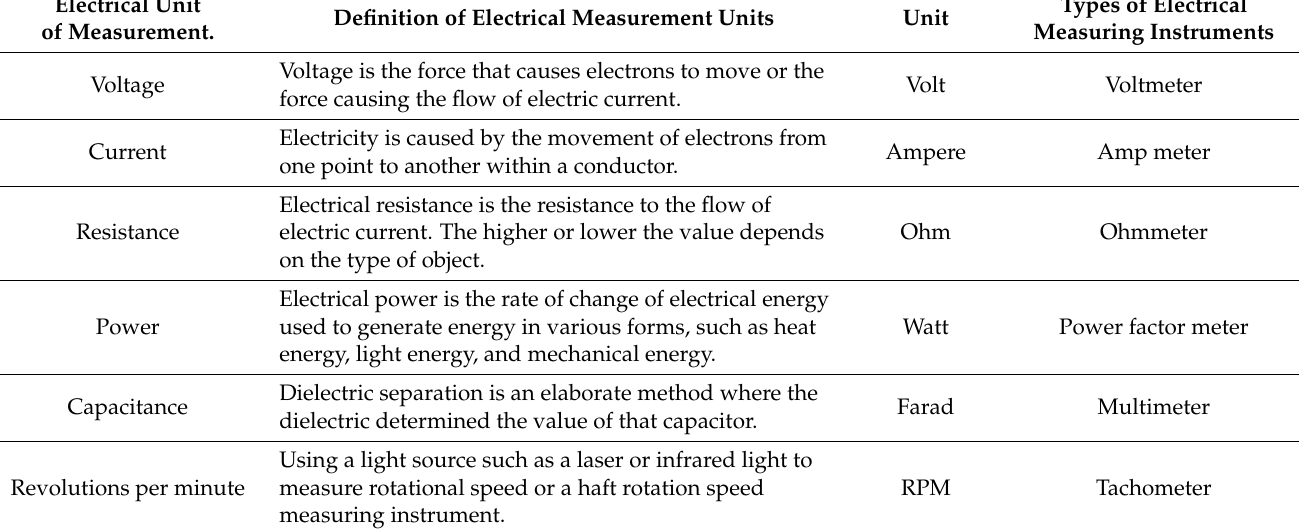
Table 4. The international units of measurement by the International System of Units (SI) define important basic electrical units and other practical electrical measurement units. Our research employed the following definitions [39].